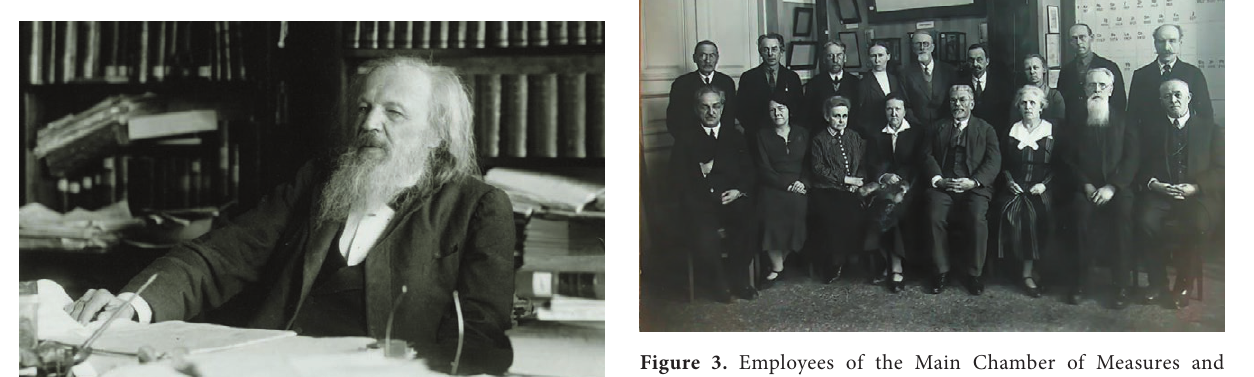
Figure 3. Employees of the Main Chamber of Measures and Weights, who worked with D. I. Mendeleev, posing in the first exhibit of the museum. Among them: Mikhail Mladentsev (for- mer MCWM Scientific Secretary, sitting first from the left), Alexey Skvortsov (former personal secretary of D. I. Mendeleev, standing second from left), Alexander N. Dobrokhotov (standing third from left), Victor Mueller (standing fifth from left) and etc. Photo from the collection of the Metrology Museum hosted by the D.I. Mende- leyev Institute for Metrology,